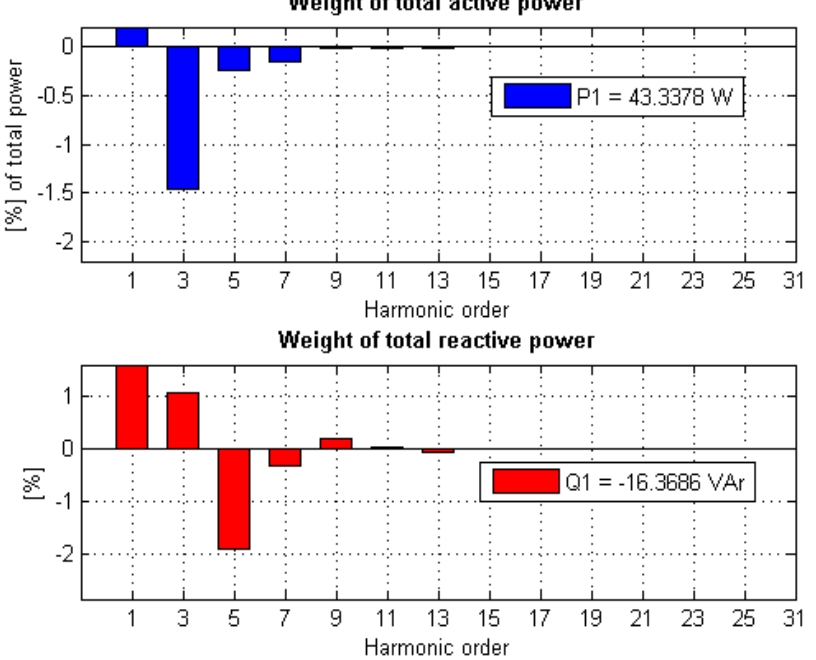
Figure 9. Weights of active powers ( top ) and reactive powers ( bottom ) for harmonic weights exceeding 1% from the component oscillating at 50 Hz, up to the maximum harmonic of 31. The values of ITHD yielded by the FFT analysis were found to overcome the upper limit of 8%, mentioned for the studied equipment in both IEEE 519-2014 Standard [12] and EN 50160